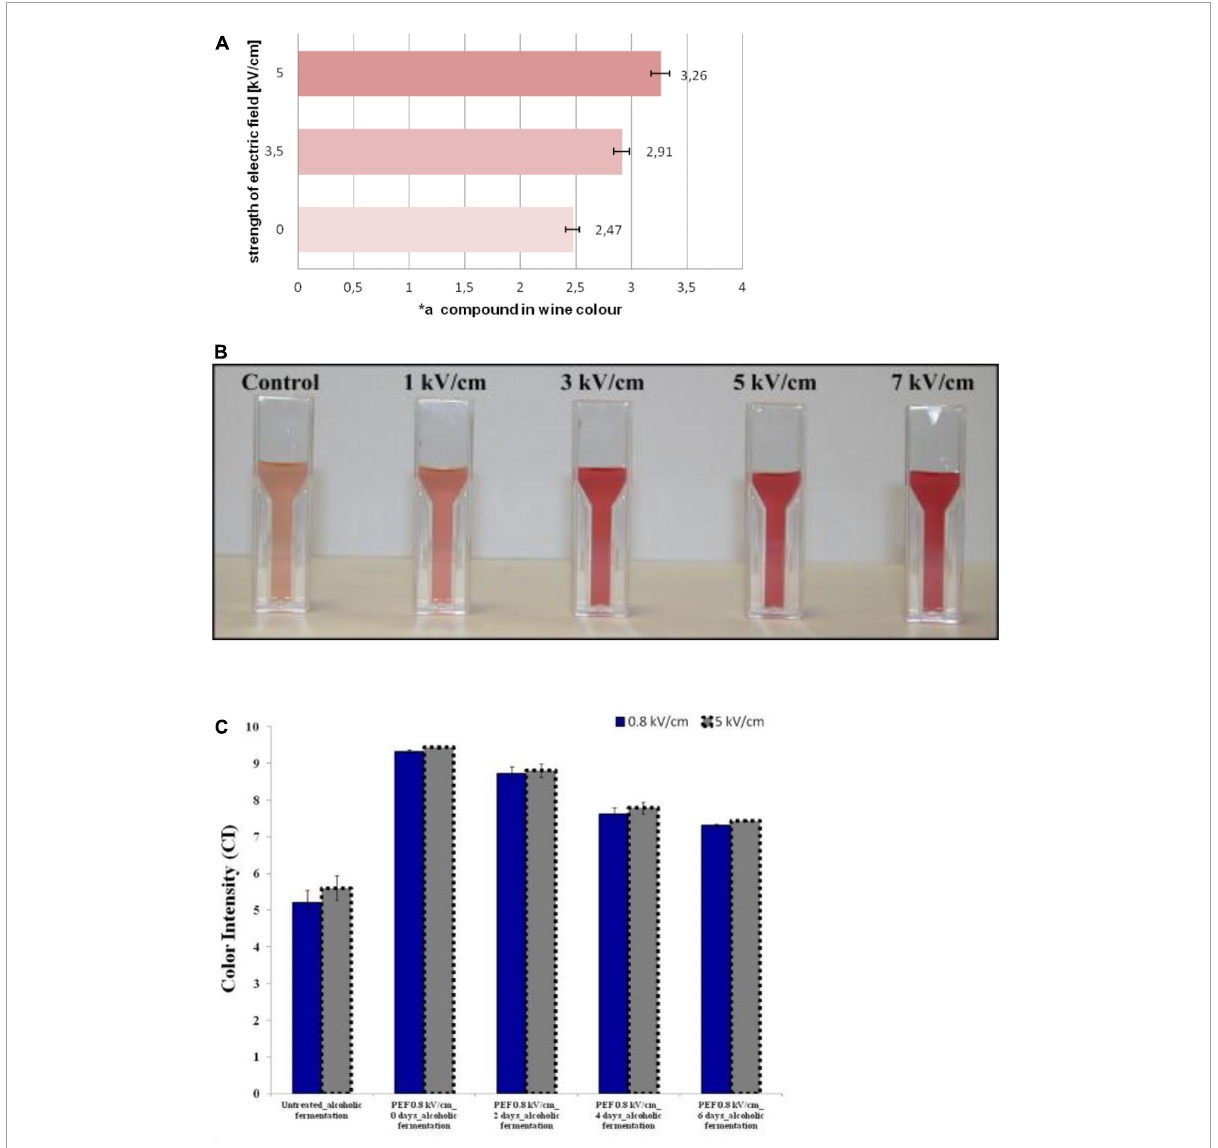
FIGURE2 (A) Share of the red component (*a) in the color of the control group and PEF treatment (3.3 and 5 kV/cm) wines. Reprinted from Puértolas et al. (48). (B) The color of the Garnacha must significantly enhanced with the increase of PEF treatment (1–7 kV/cm, 0.4–4.1 kJ/kg, 50 pulses). Reprinted from Hui et al. (85). (C) Color intensity (CI) at t = 0, 2, 4, and 6 days of Alcoholic Fermentation using both high (5 kV/cm) and moderate (0.8 kV/cm) PEF. Reprinted from El Darra et al.